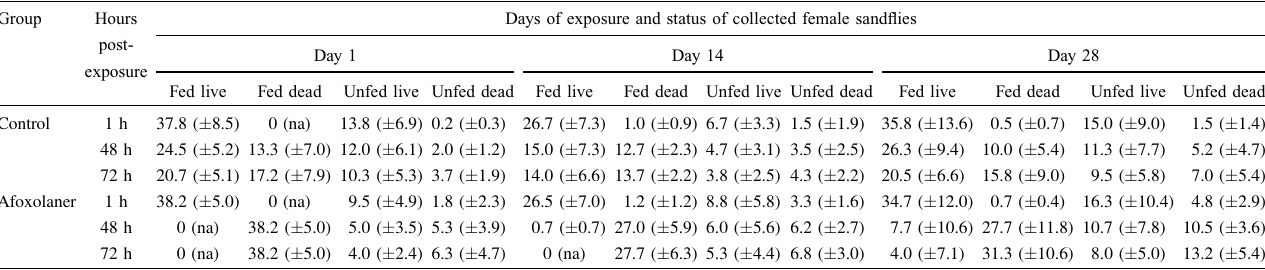
Table 1. Arithmetic means ( (cid:1) 95% con fi dence interval [CI], a = 0.05) for female sand fl ies status at 1, 48, and 72 h post-exposure.